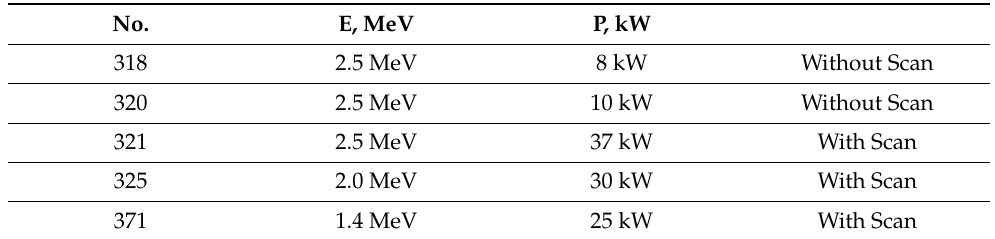
Table 2. Synthesis modes. The serial number in the table is the sample number in the accounting system used by the